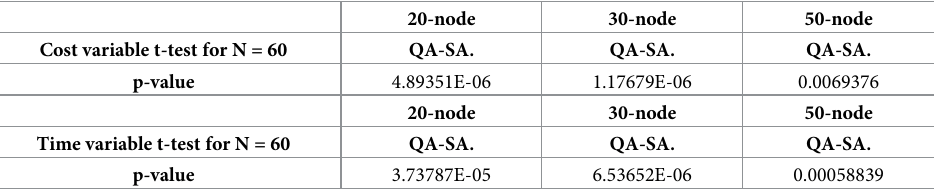
Table 25. Comparison matrix for the two-tailed t-test independent means p-values for the test cases with nodes with n = 20, 30, 50 and sample size N =